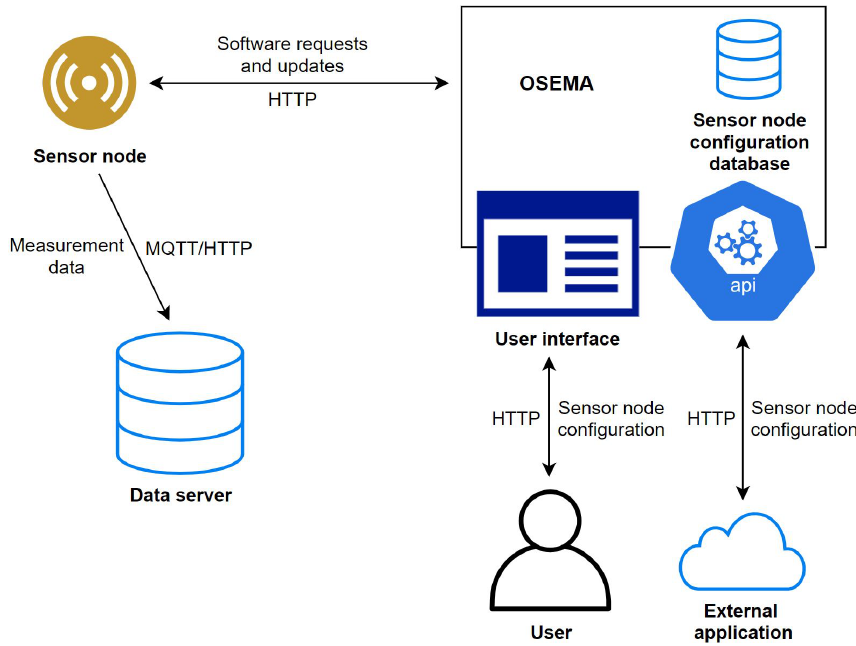
Figure 3. Detailed overview of a measurement setup.